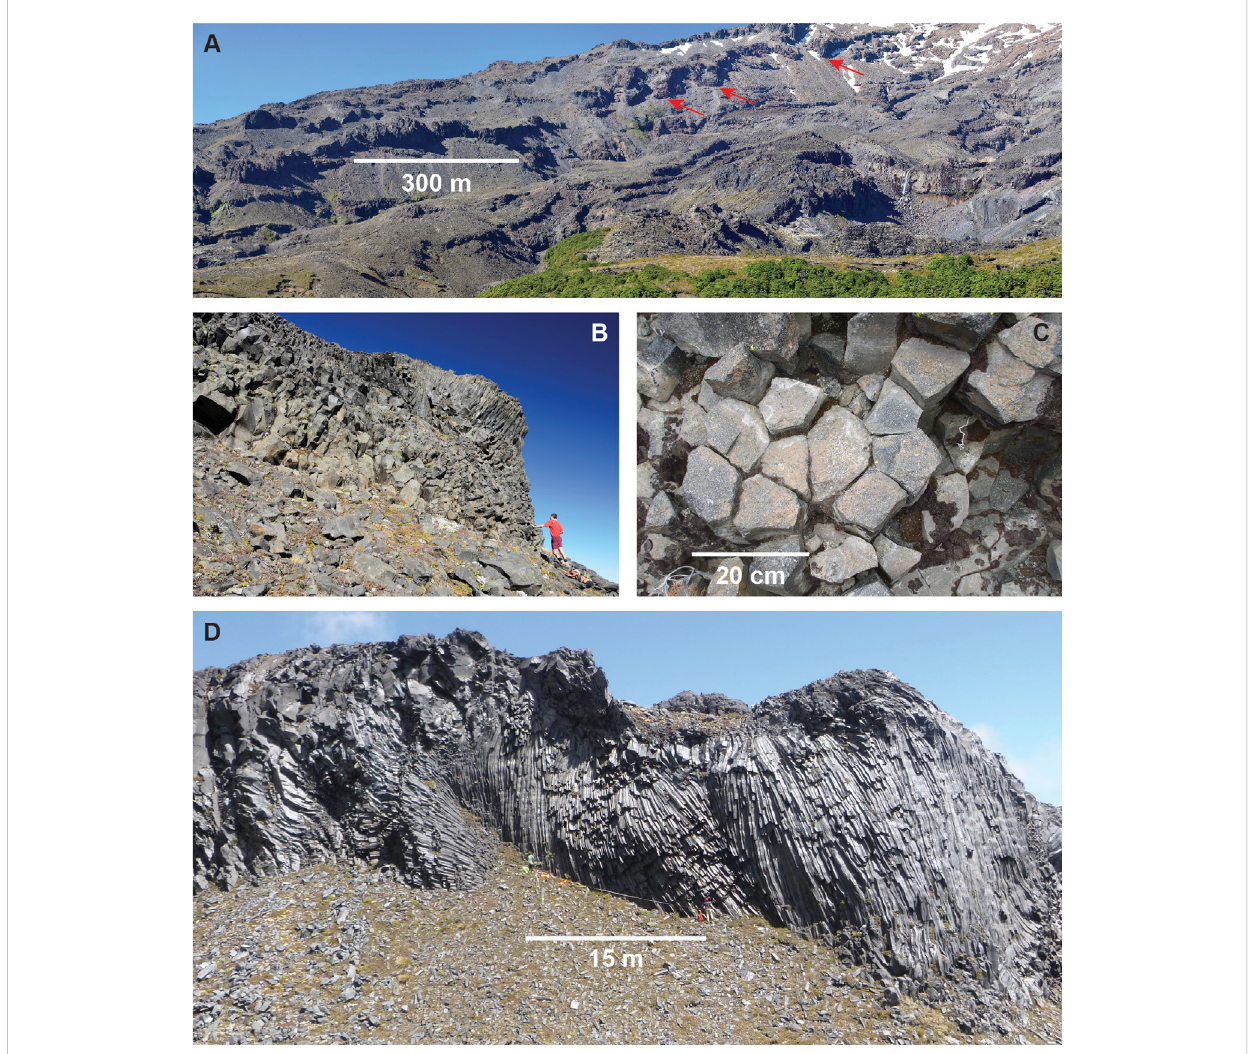
FIGURE 2 Examples of ice-bounded lava fl ows at Mount Ruapehu, New Zealand. (A) Thick lavas on the northern ridge of the Mangaturuturu valley on the southwestern fl ank,whichwereemplacednexttoglacialicebetween~45 – 20 ka.Redarrowspointto “ knuckles ” oflava.PhotographprovidedbyDougal Townsend. (B) Column-forming joints on the margin of an ice-bounded lava fl ow on the western fl ank. Photograph provided by Dougal Townsend. (C) Cross-section view of “ columns ” with diameters of ca. 10 cm on an ice-bounded lava fl ow on the southeastern fl ank. (D) Fanning column-forming joints in an ice-bounded lava fl ow on the northwest fl ank. People are standing 15 m